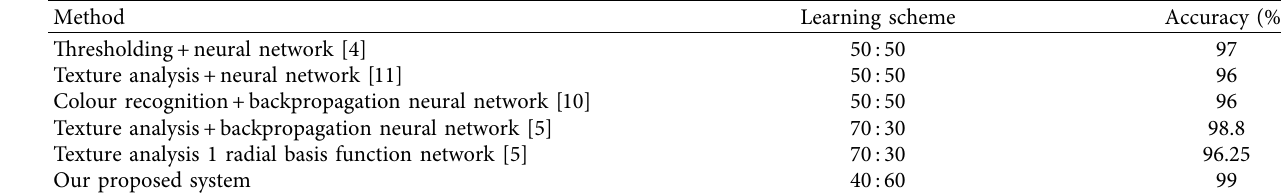
Table 3: Model performance comparison with other previous